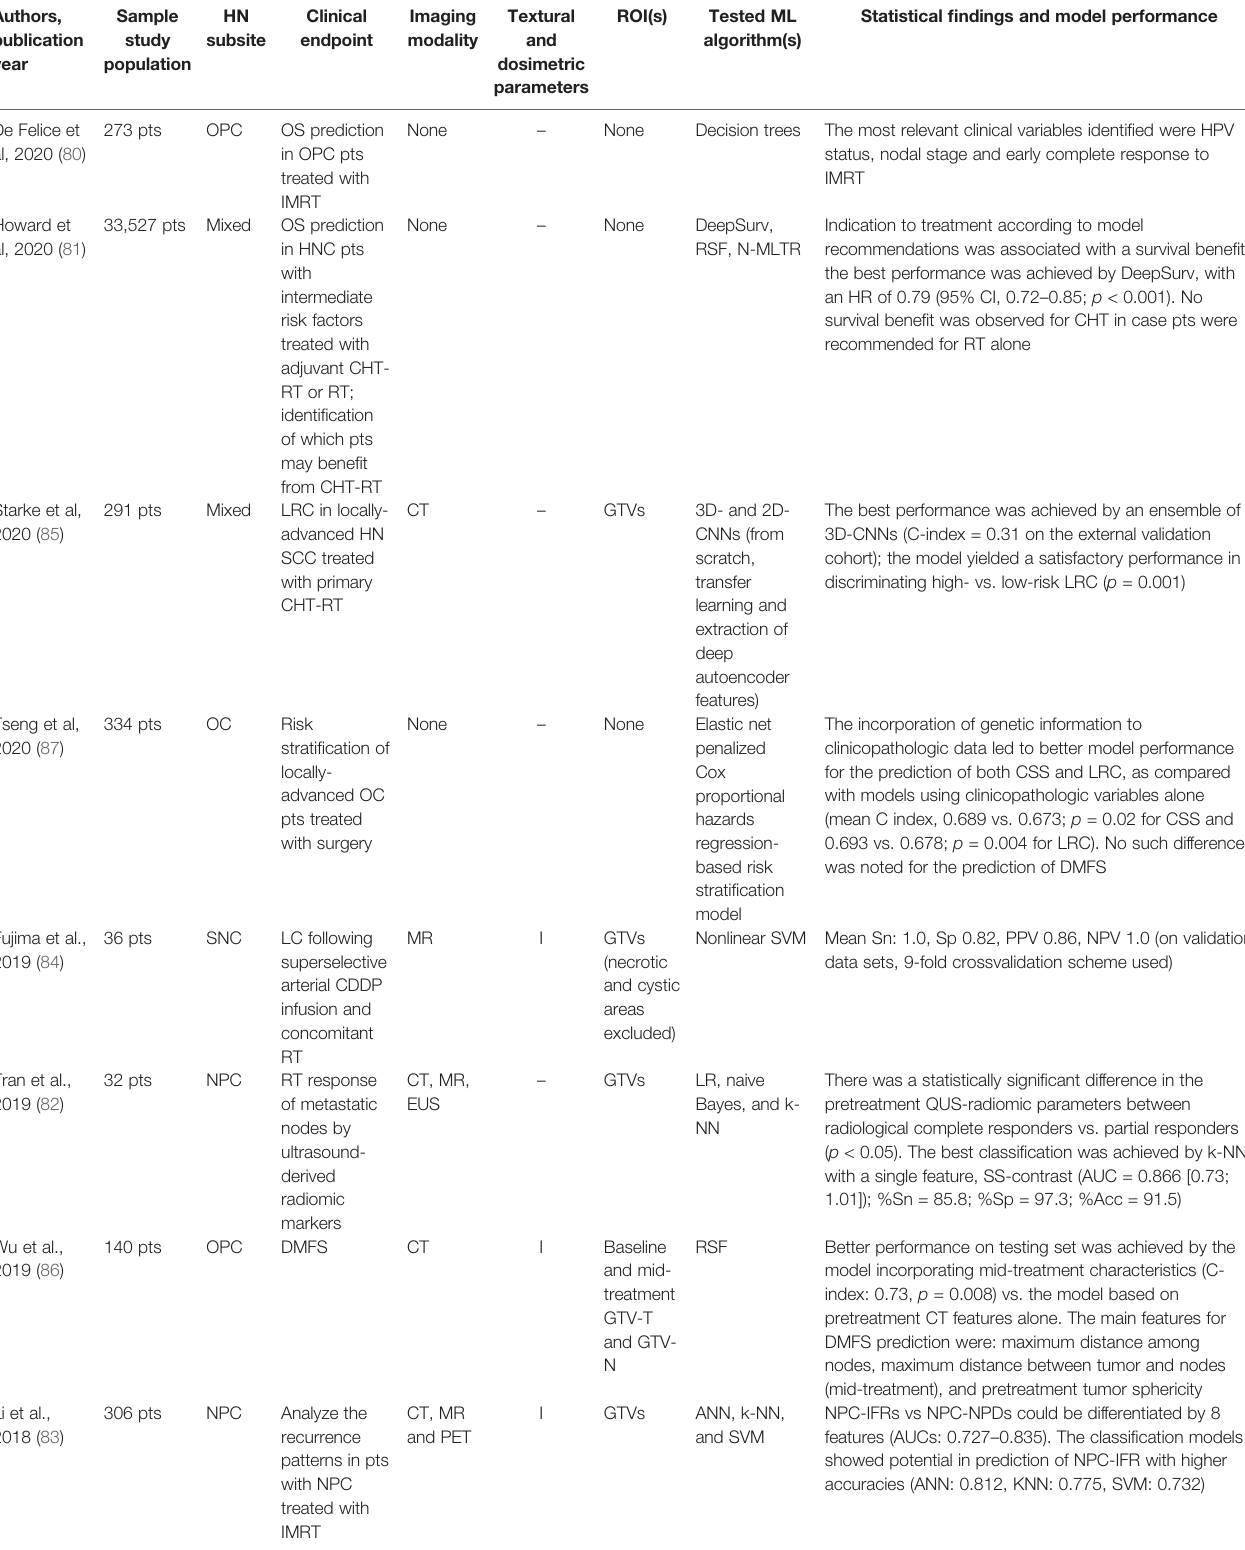
TABLE 4 | Characteristics for machine-learning studies on oncological